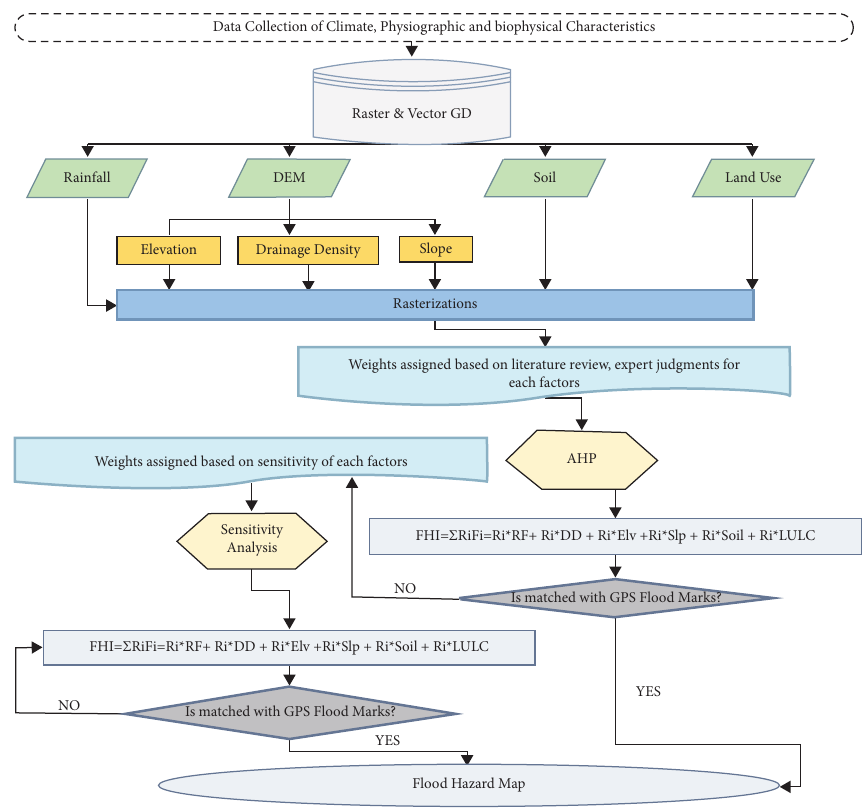
Figure 2: Flowchart for the food hazard zoning